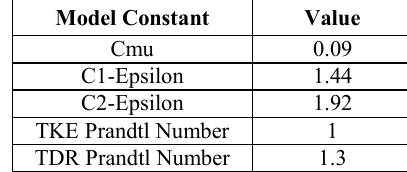
Table 2. Turbulence model